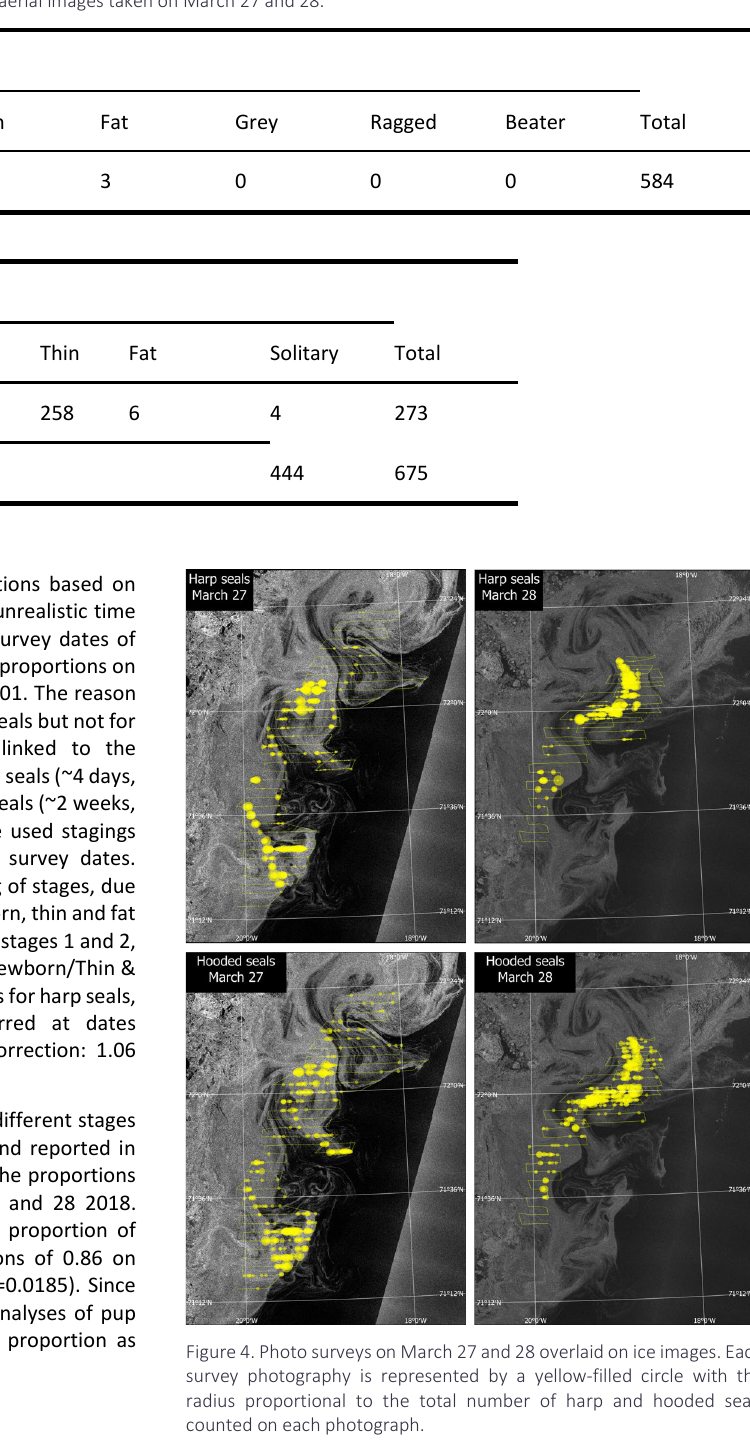
Table 1. A) Number of harp seal pups in individual age dependent stages in the Greenland Sea. Numbers obtained during helicopter staging surveys on March 21, 2018. B) Number of hooded seal pups in individual age dependent stages in the Greenland Sea. Numbers obtained during helicopter staging surveys on March 21, 2018, or from stagings done from aerial images taken on March 27 and 28.